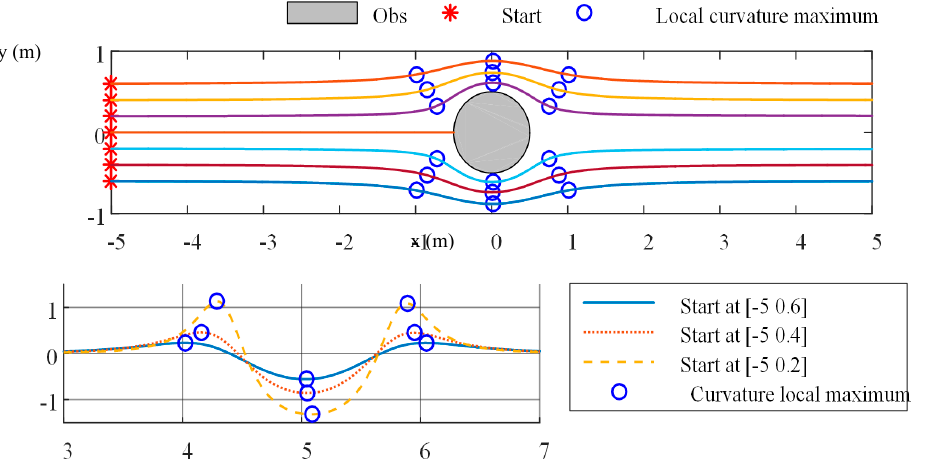
Figure 5. The streamline paths (upper plot) with different start positions and their curvatures (lower plot) for a uniform flow around a circular obstacle. The path to avoid an obstacle is similar to the streamline of the fluid flow around a cylinder. The very large turning radii of some of the paths closer to the obstacle may become infeasible when the curvature constraint imposed on the vehicle motion is accounted for.